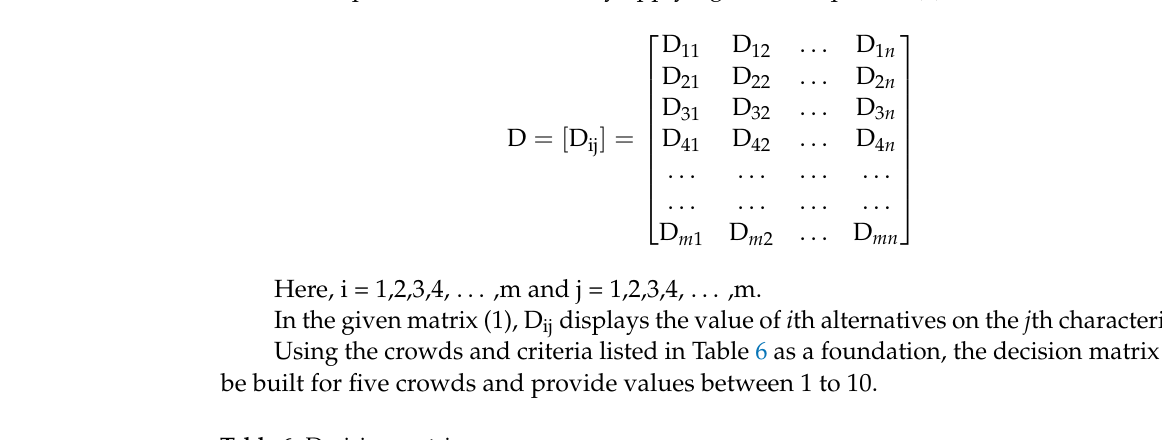
Table 6. Decision